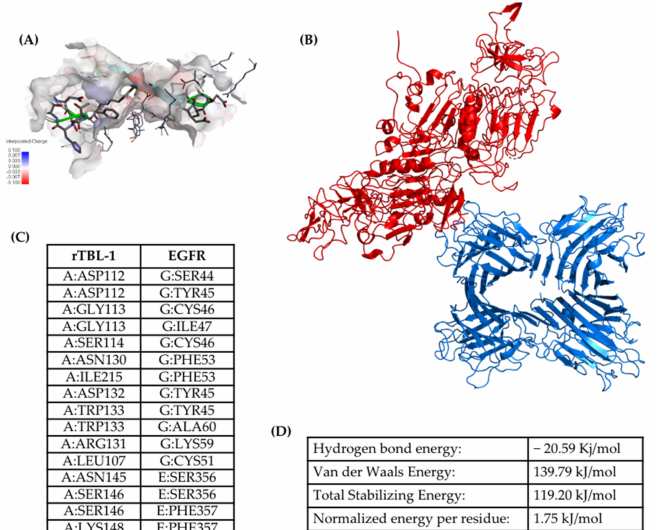
Figure 8. Docking of rTBL-1 and EGFR. ( A ) Topological representation of the protein–protein interac- tion zone showing EGFR-interacting residues as sticks. ( B ) The interaction between rTBL-1 and EGFR shows rTBL-1 and EGFR as blue and red ribbons, respectively. ( C ) Table with docking-interacting residues: A—Chain A of rTBL-1; E and G—Chain A and chain C of EGFR protein, respectively. ( D ) Standard energy calculation of the rTBL-1 and EGFR interaction measured by hydrogen bond energy and Van der Waals energy. Normalized energy per residue was obtained by dividing all non-bonded interactions by the total number of interface residues